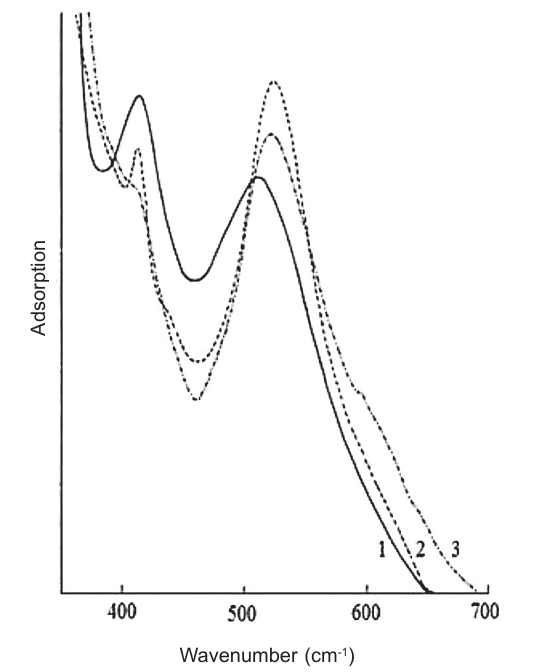
Fig. 3 – Visible absorption spectra of (1) Fe(III) MMT react- ed with pyrrole and 1-naphthaldehyde, (2) Zn(II) MMT reacted with pyrrole and salicylaldehyde, (3) Ni(II) MMT reacted with pyrrole and 4-carboxybenzaldehyde. The spectra were taken as suspensions in chloroform after less than 5